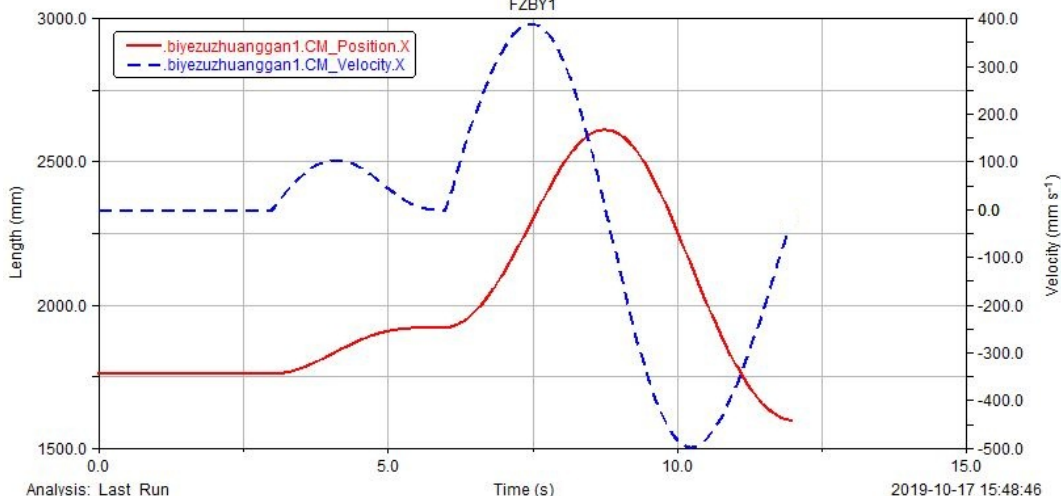
Figure 22. Assembly displacement and velocity curve of robot